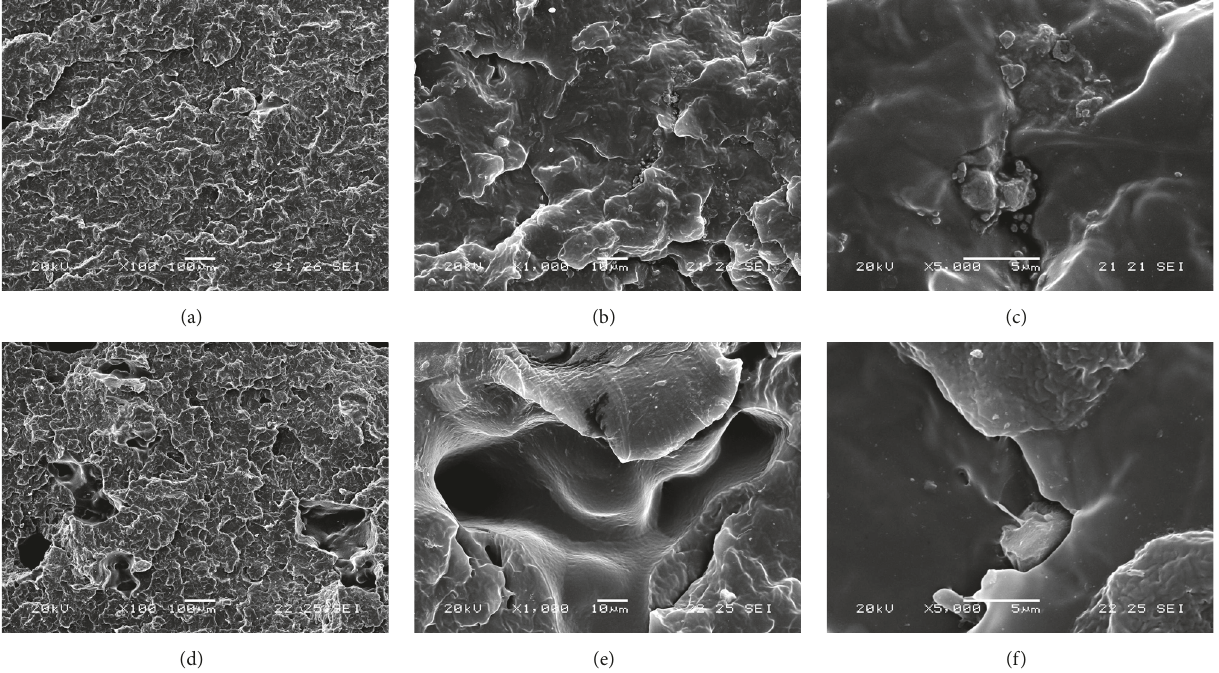
Figure 10: The SEM picture of the tensile test section and impact test section. (a), (b), (c): tensile test section; (d), (e), (f): impact test section.